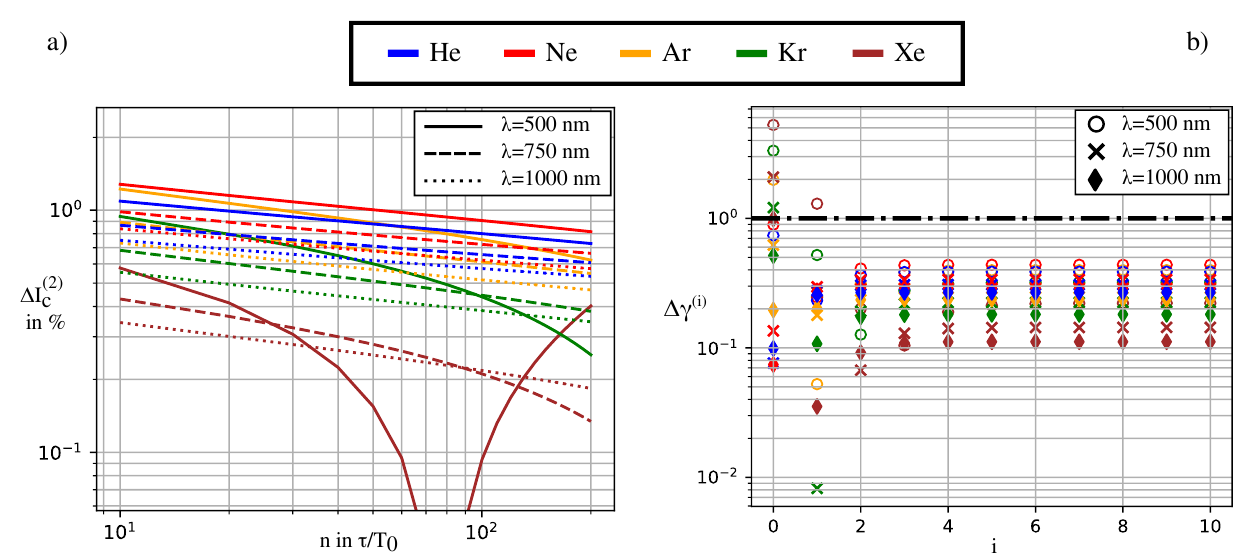
Figure 3. ( a ) The error of the critical intensity (log scale) as a function of the pulse duration (log scale) was calculated within the PPT model. The error is shown for wavelengths of λ = 500,750,1000nm (line type) in neutrally charged noble gases (line color). ( b ) Error of the Keldysh parameter (log scale) for a pulse of n = 200 optical periods (FWHM) about the number of iterations i . The set of wavelengths (marker style) and noble gases (line color) is the same as in